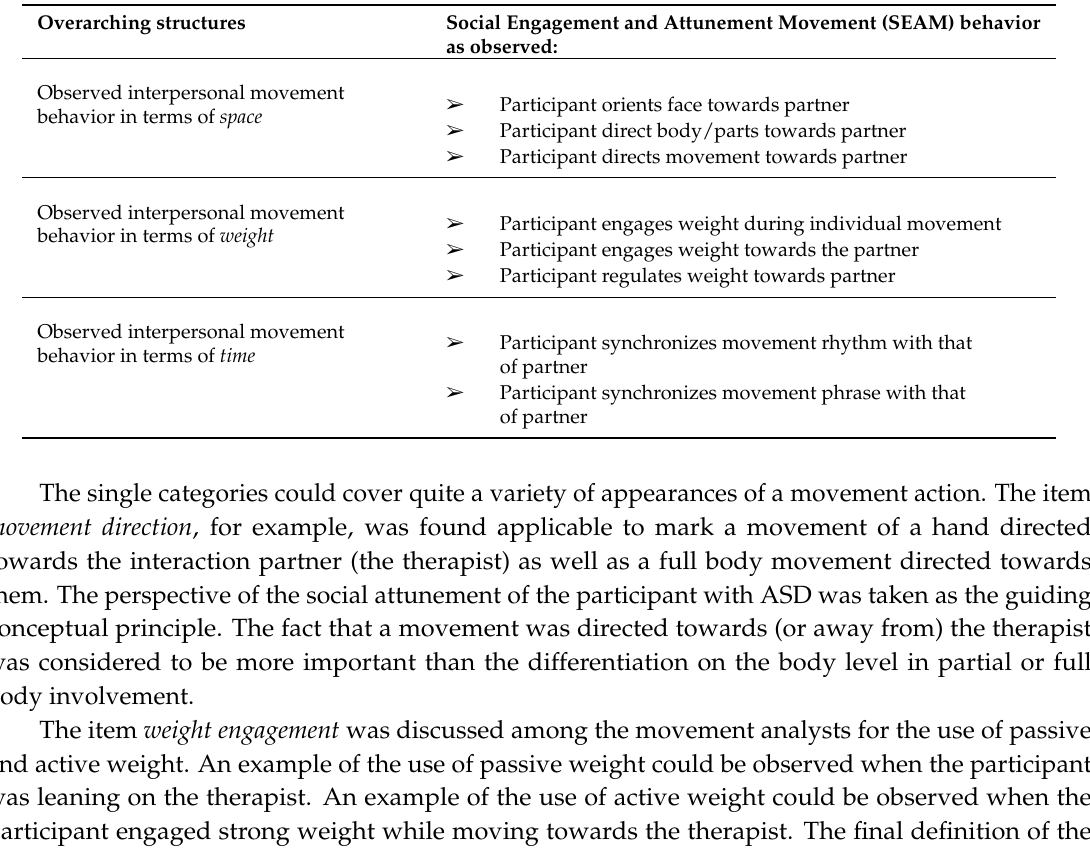
Table 1. Overview of interpersonal movement